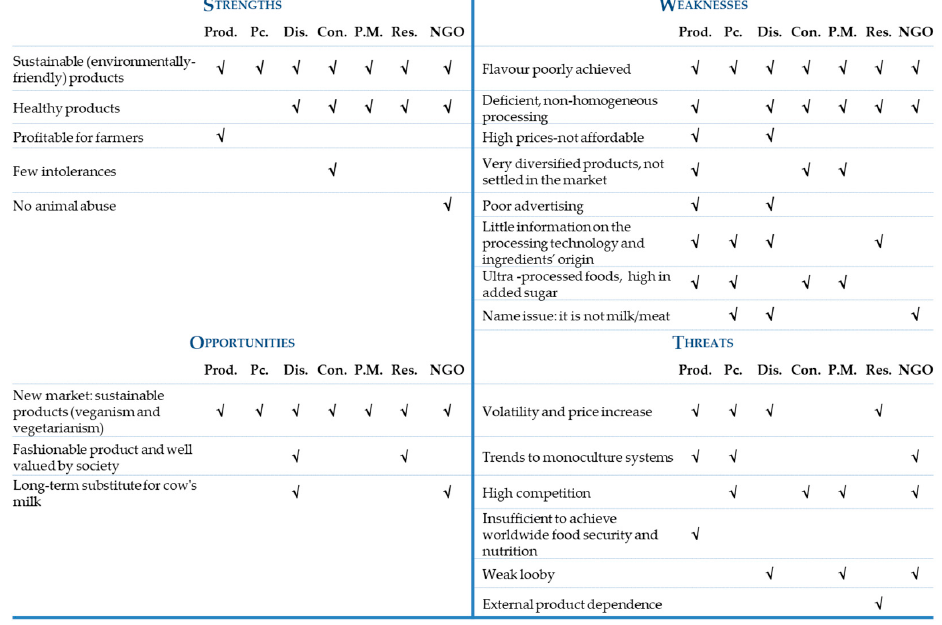
Figure 8. Strengths, Weaknesses, Opportunities, Threats (SWOT) analysis of innovative protein-rich plant-based products. Stakeholder groups: Prod. (producers), Pc. (processors), Dis. (distributors), Con. (consumers), P.M. (policy-makers), Res. (researchers), NGO (non-governmental organization).